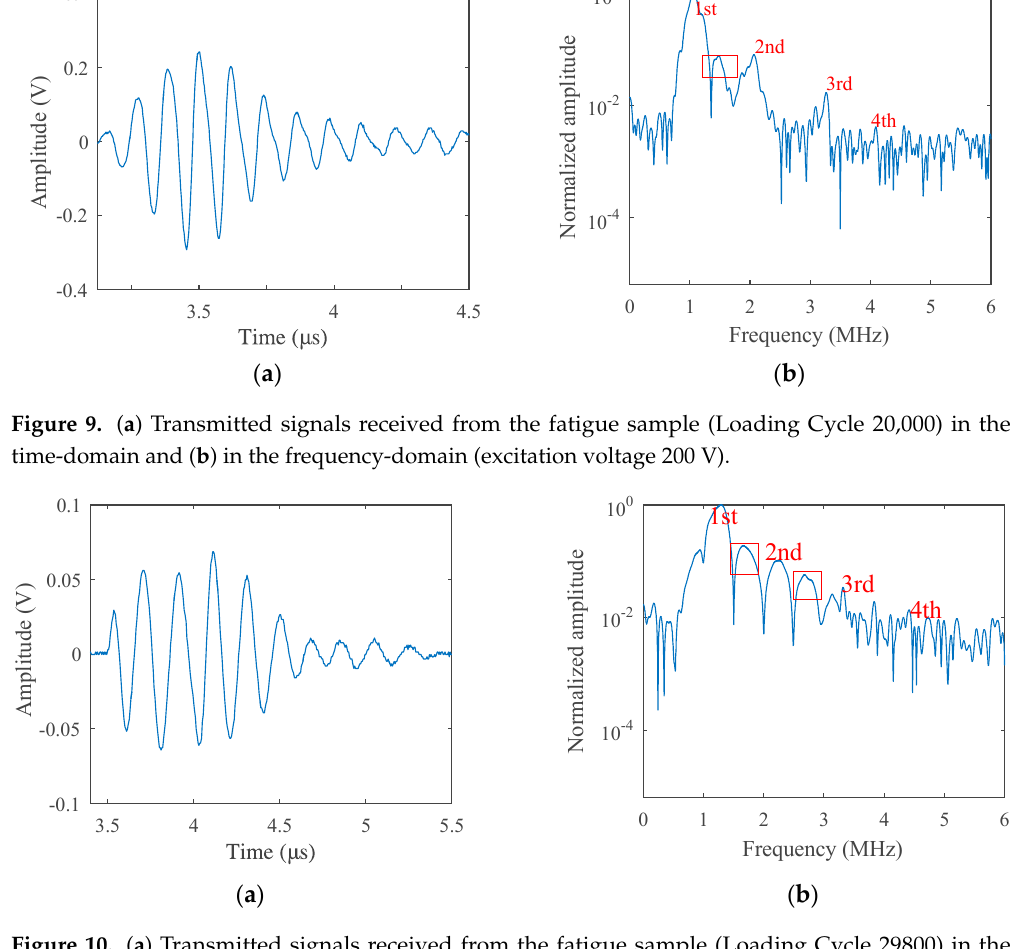
Figure 10. ( a ) Transmitted signals received from the fatigue sample (Loading Cycle 29800) in the time-domain and ( b ) in the frequency-domain (excitation voltage 200 V).